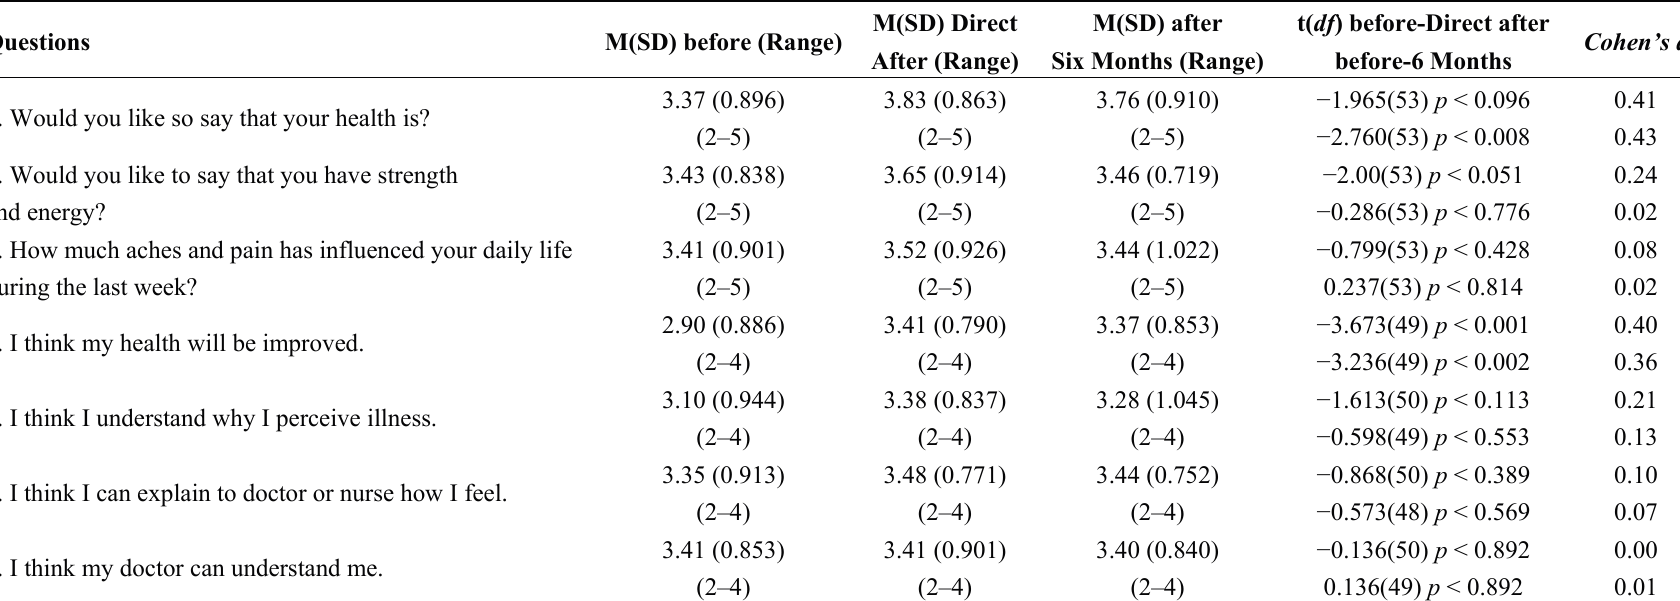
Table 4. Perception of health among female participants in a five weeks’ intervention in Södertälje, before, direct after and at six months follow up (N = 54) the whole group of